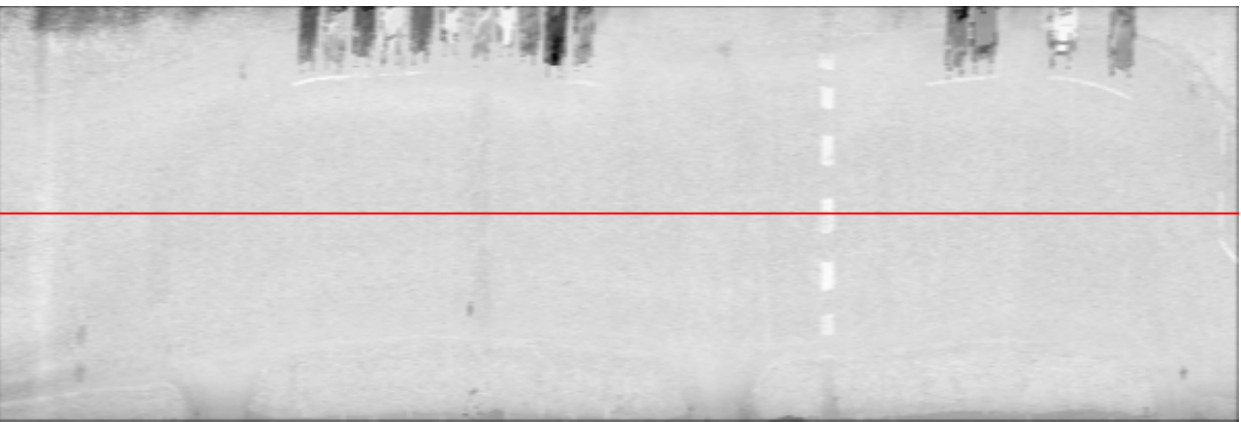
Figure 4. Pre-processed intensity image showing the centreline corresponding to pixel 0 of each profile in